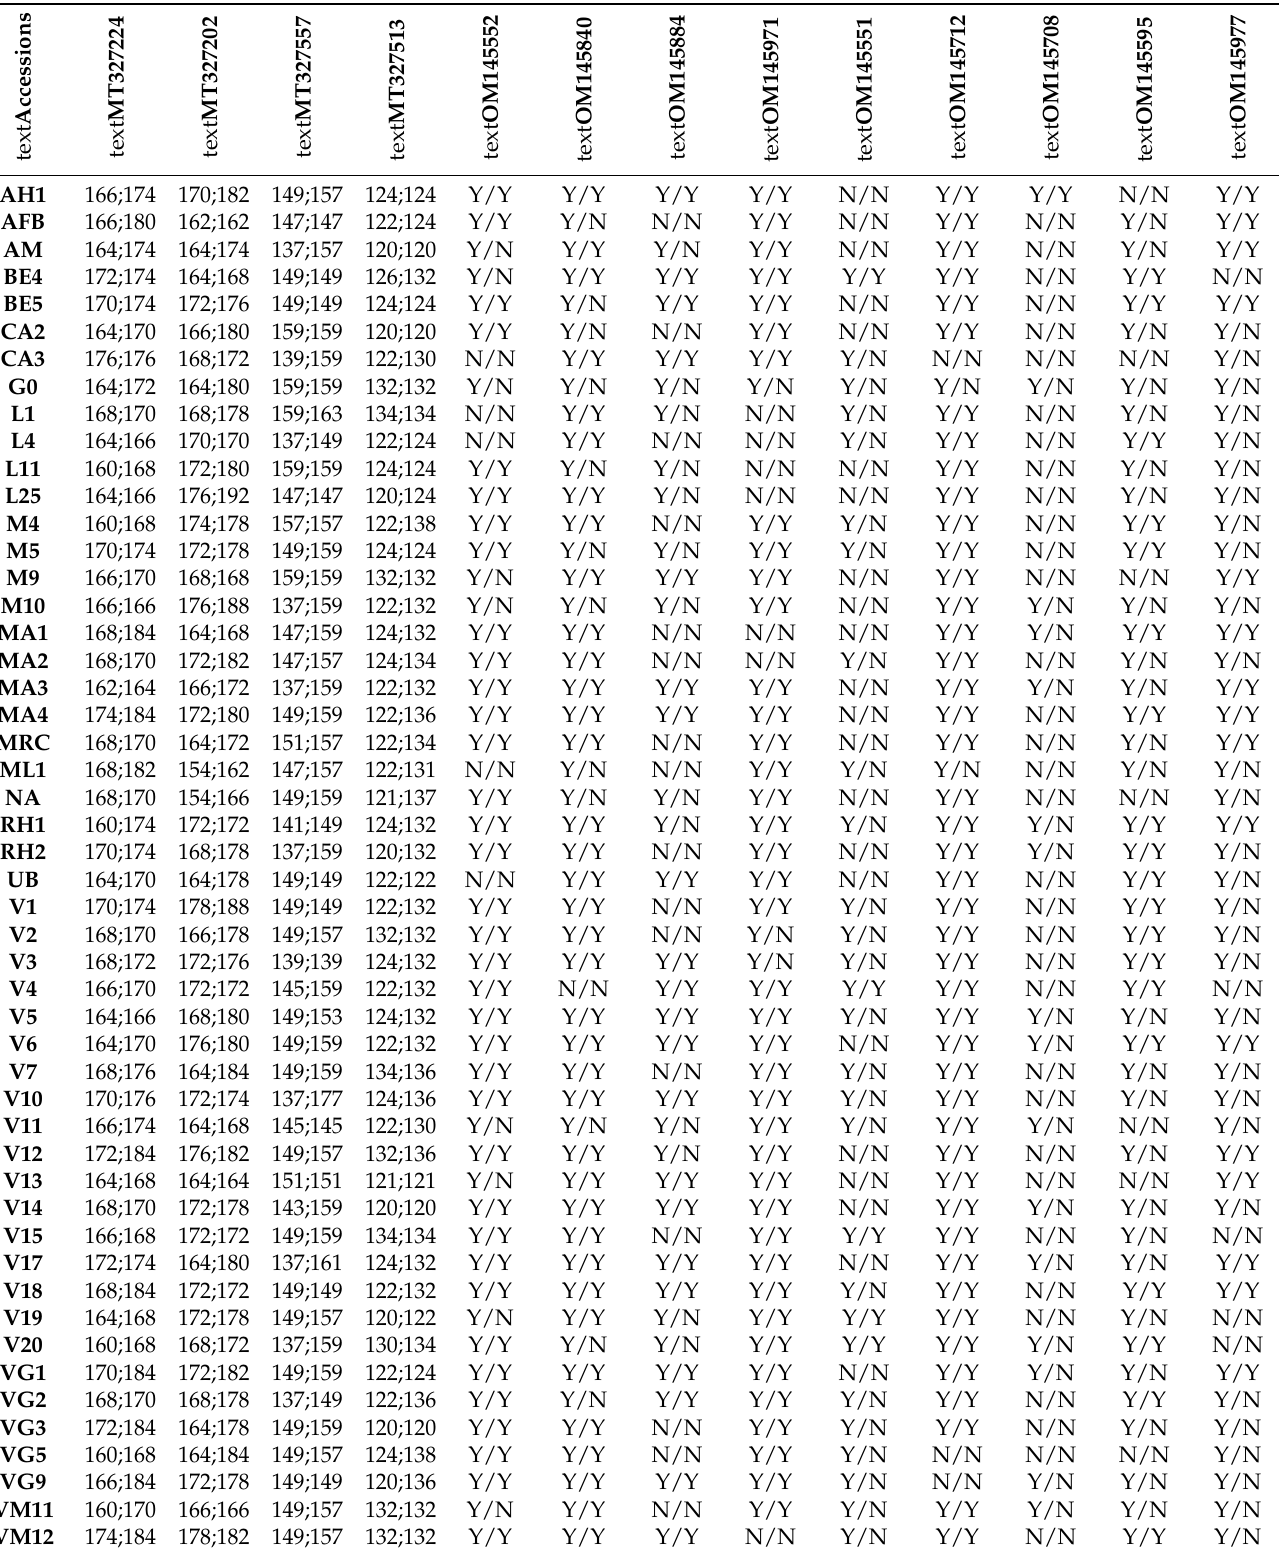
Table 2. Molecular fingerprints of the 50